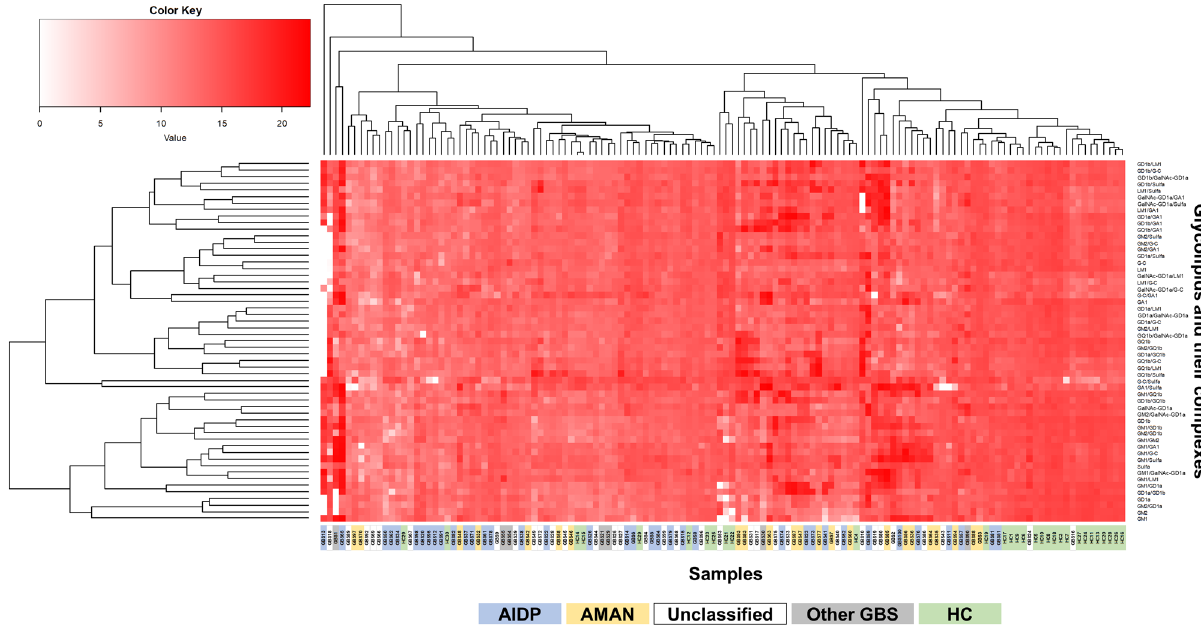
Figure 4. A heat map of serum glycolipid IgG antibody titers in GBS subtypes and HC. We quantified 10 glycolipid and 45 glycolipid complex antibodies by IgG glycoarray and aligned individual samples, using hierarchical clustering. Each row represents glycolipid antibody titers against a single glycolipid antigen, and each column represents a single serum sample. Red density corresponds to the antibody titer level; white indicates the absence of the antibody. A dendrogram at the top is the hierarchical clustering based on antibody titer patterns of individual serum samples. Color bars at the bottom of the heat map indicate that the samples from AIDP, blue; AMAN, orange; “Unclassified,” white; “Other GBS,” gray; and HC, green, showing the dispersal of GBS subgroups and HC samples. This analysis did not segregate the GBS and HC samples into two distinct groups based on the antibody titers, although a dendrogram (at the top of the heat map) based on the patterns of antibody titers showed that the three clusters at the right side of the heat map contained 19 of 30 HC samples (and 8 of 100 GBS samples). We also did not find the segregation of patients’ samples based on GBS subgroups, although several sample groups composed of two to five samples in the same GBS subgroup showed similar patterns of antibody titers. Thus, hierarchic clustering did not distinguish samples between GBS versus HC samples or among GBS subtypes. On the other hand, a dendrogram at the left of the heat map, which is